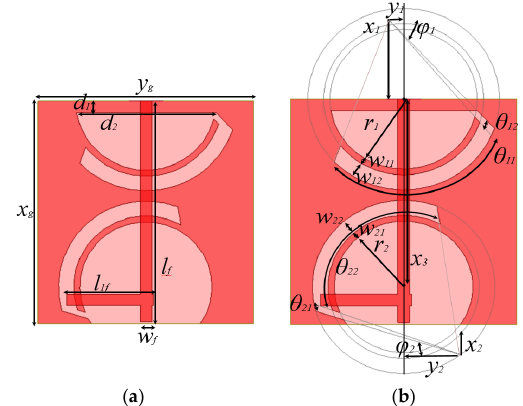
Figure 1. Design parameters of the proposed antenna, ( a ) overall optimized dimensions and ( b ) slots